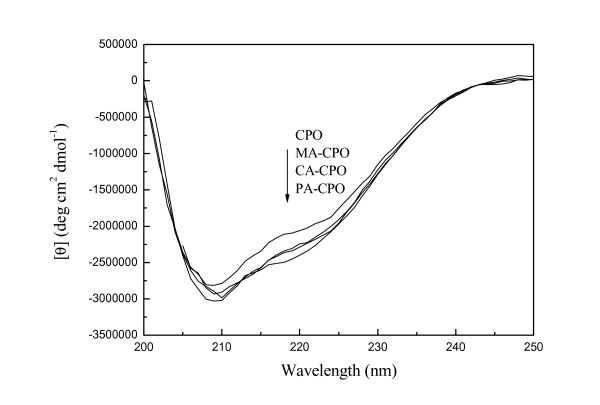
CD spectra of native and modified CPOs in 10 mM acetate buffer (pH 5.0). Enzyme concentration was 7.5 μM.